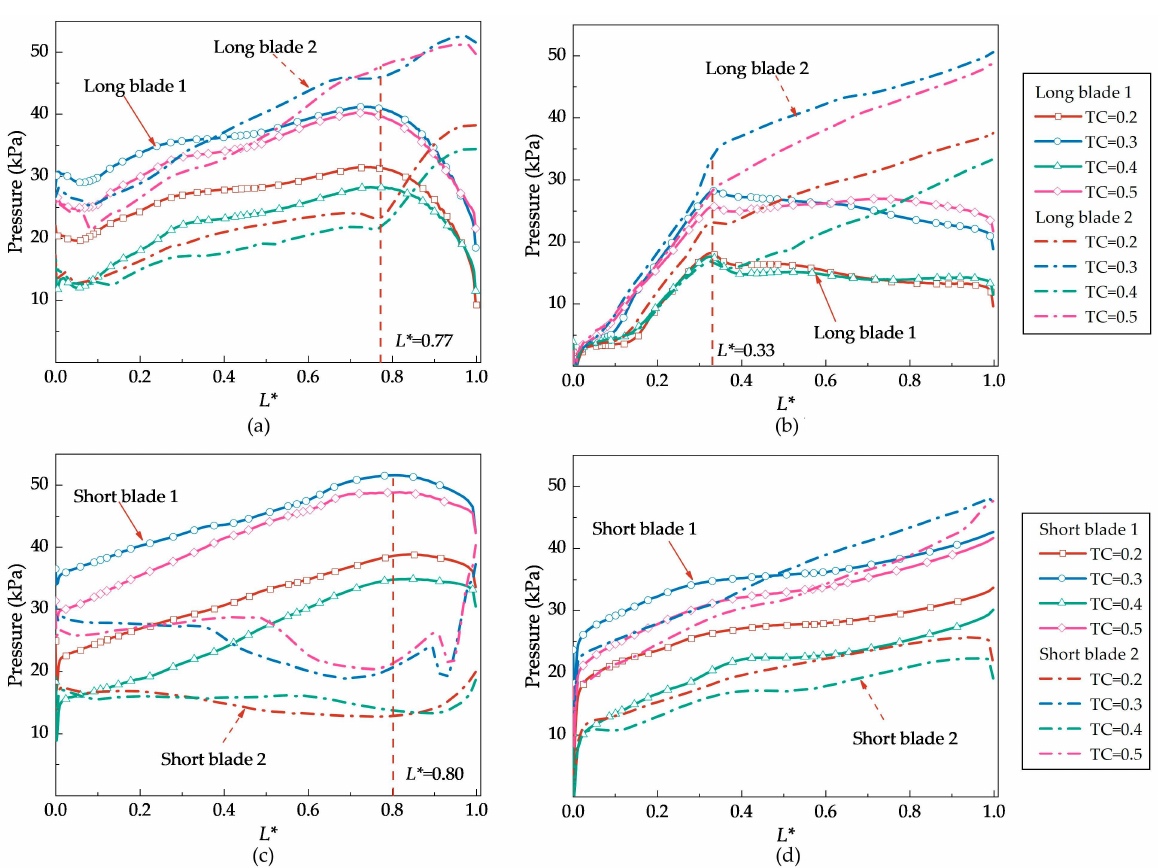
Figure 10. Long and short blades’ loads under different TCs ( σ = 0.062, R * = 0.9): ( a ) Long blade pressure surface; ( b ) Long blade suction surface; ( c ) Short blade pressure surface; ( d ) Short blade suction